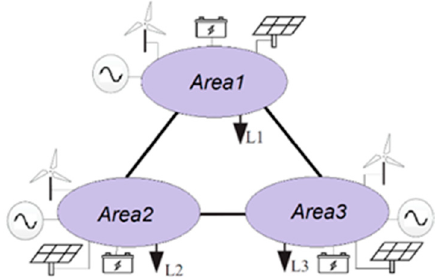
Figure 12. Three-area test system.